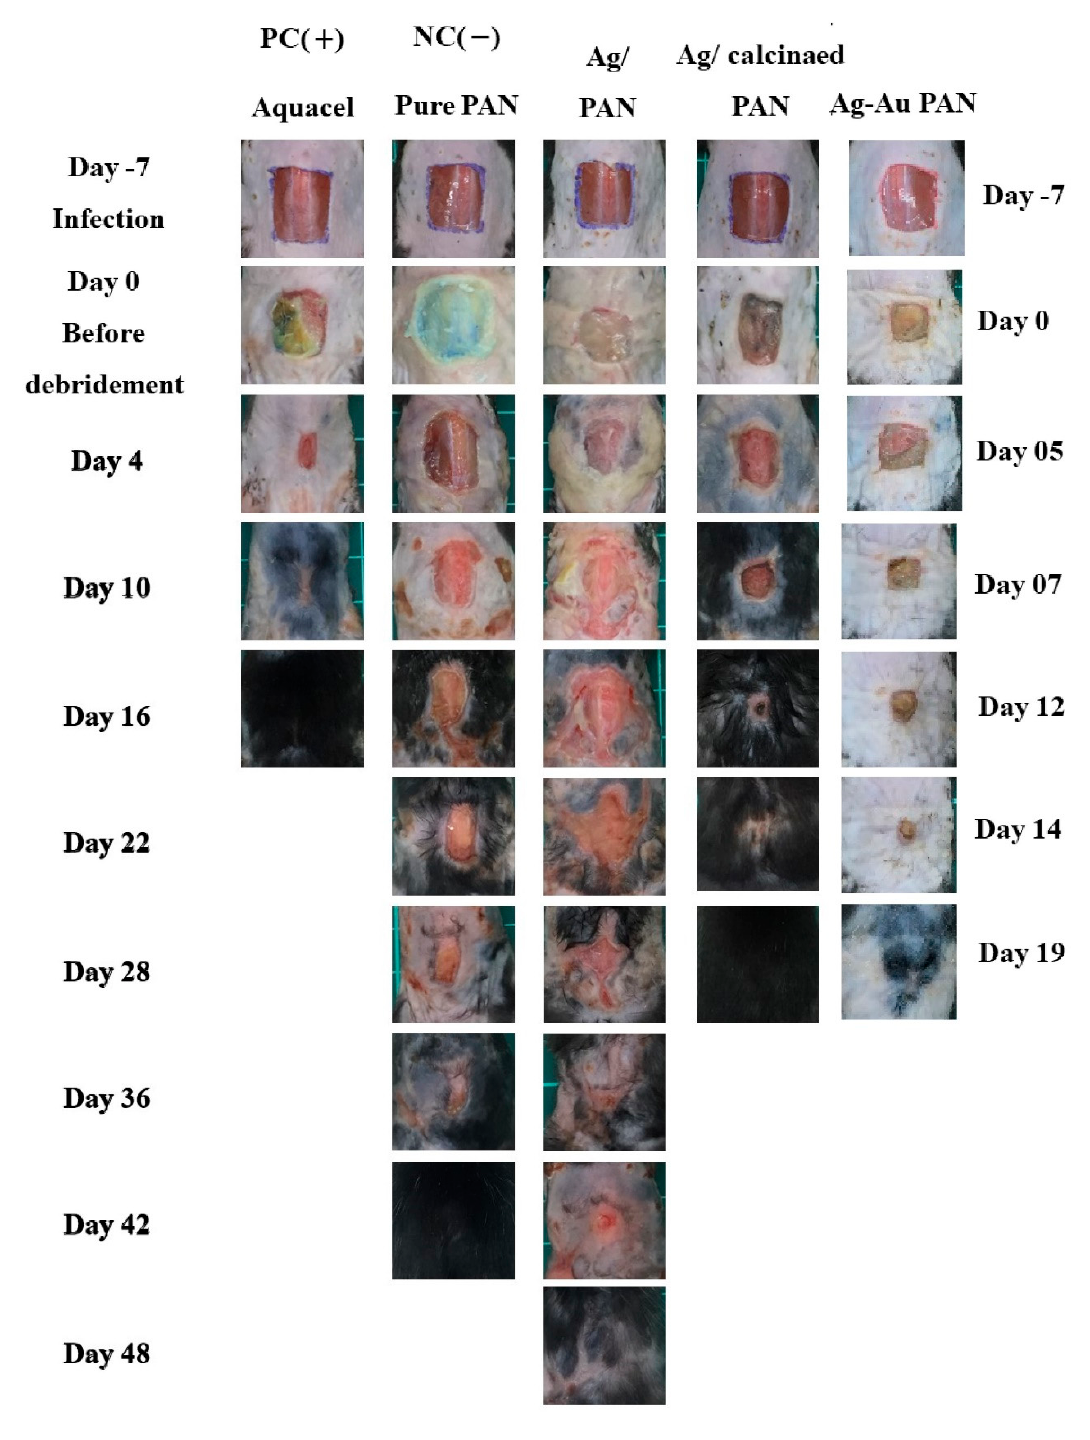
Figure 8. Optical images of two runs of animal studies for evaluating two major different nonwoven mats, i.e., Ag-based/PAN and urchin-like Ag–Au/PAN nonwoven mats. The left scale bar was versus group PC, NC, Ag/PAN, and calcined Ag/PAN nonwoven mats. The right scale bar was versus urchin-like Ag–Au/PAN nonwoven mats. Changes in wound size in mice in infection experiments and wound area recorded over time.